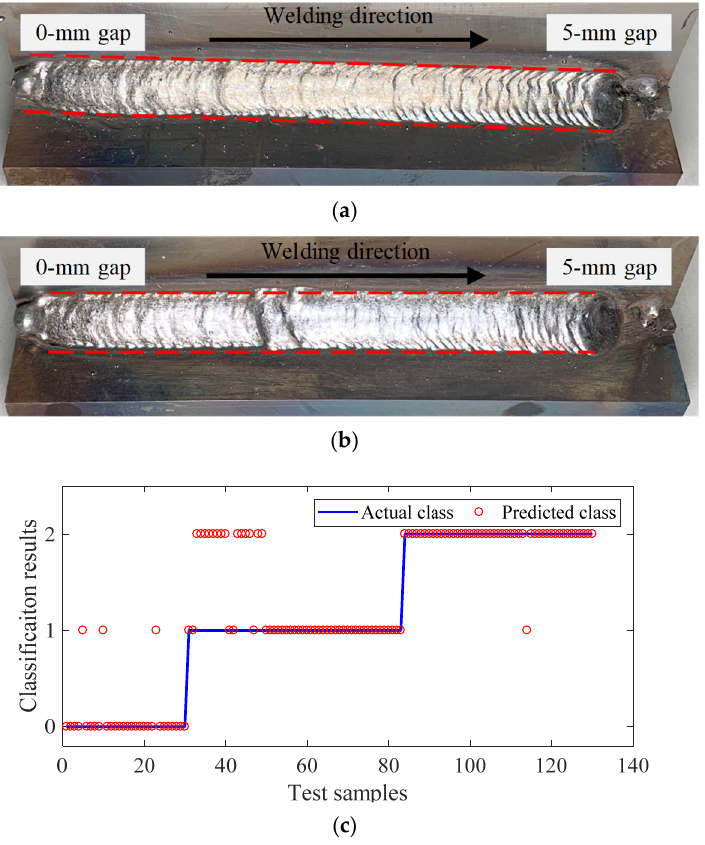
Figure 14. Online weld gap monitoring and robot control results (applied robot motion 1): ( a ) weld bead shape of linearly increasing gap regions (without robot control), ( b ) weld bead shape of linearly increasing gap regions (with robot control), and ( c ) real-time weld gap monitoring results. Table 8. Real-time weld gap detection performance of the proposed DNN model (increasing gap). Correctly Variable Support Error Accuracy % Average Accuracy % Estimated Class 0 (0 mm gap)